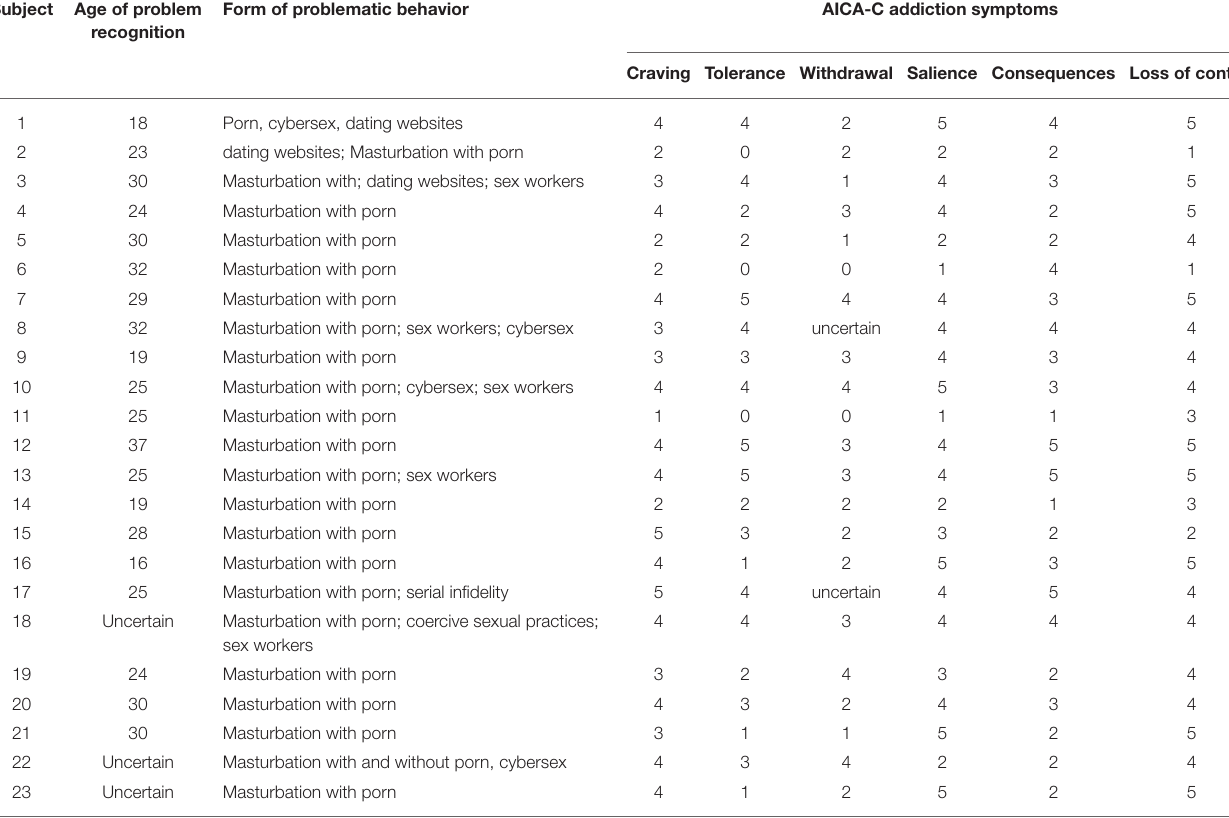
TABLE 2 | Participants’ characteristics in relation to problematic sexual internet use. Subject Age of problem